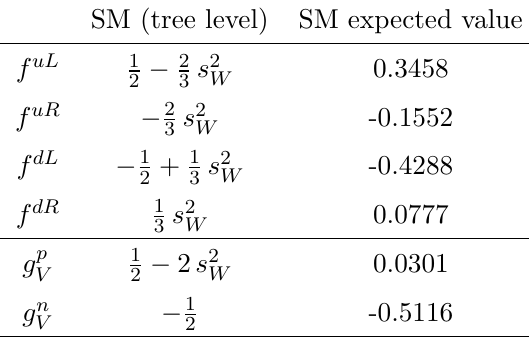
Table 1 . SM values of the up- ( u ) and down-quark ( d ) couplings to the Z boson, for left- and right-handed particles ( L and R , respectively); as well as the vector couplings for protons ( p ) and neutrons ( n ). Here, s 2 (cid:17) sin 2 (cid:18) W , where (cid:18) W is the weak mixing angle. The expressions on the left W column correspond to the tree-level couplings in the SM. The values on the right column are taken from ref. [67] (see 2019 update) and include propagator as well as vertex and box corrections, as detailed in ref.